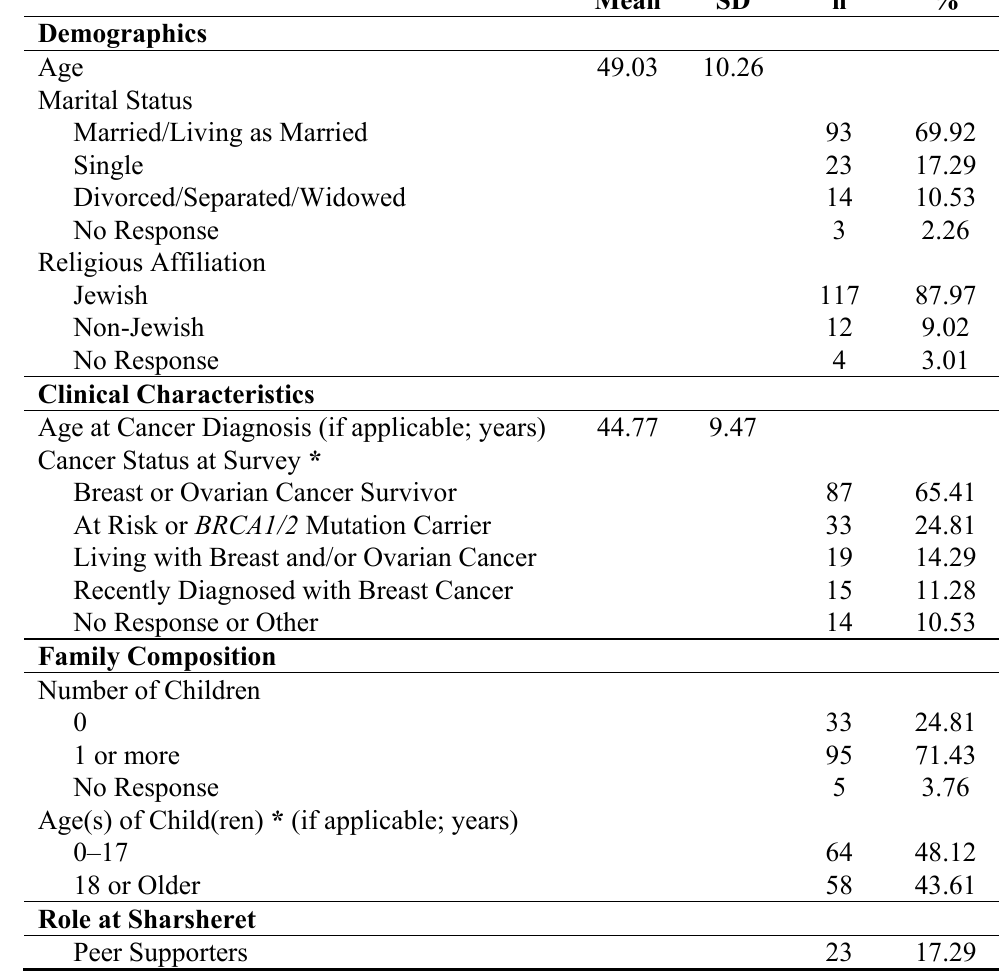
Table 1. 2013 Survey Respondent Characteristics ( n = 133).